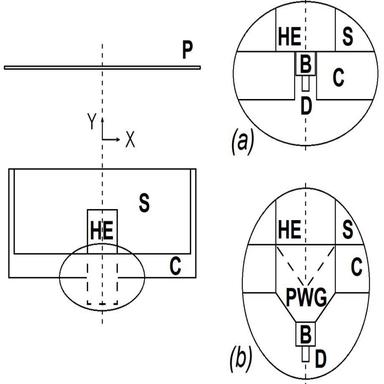
Schematic of the axisymmetric buried charge validation test setup with two loading regimes: configuration U (a) and configuration V (b).